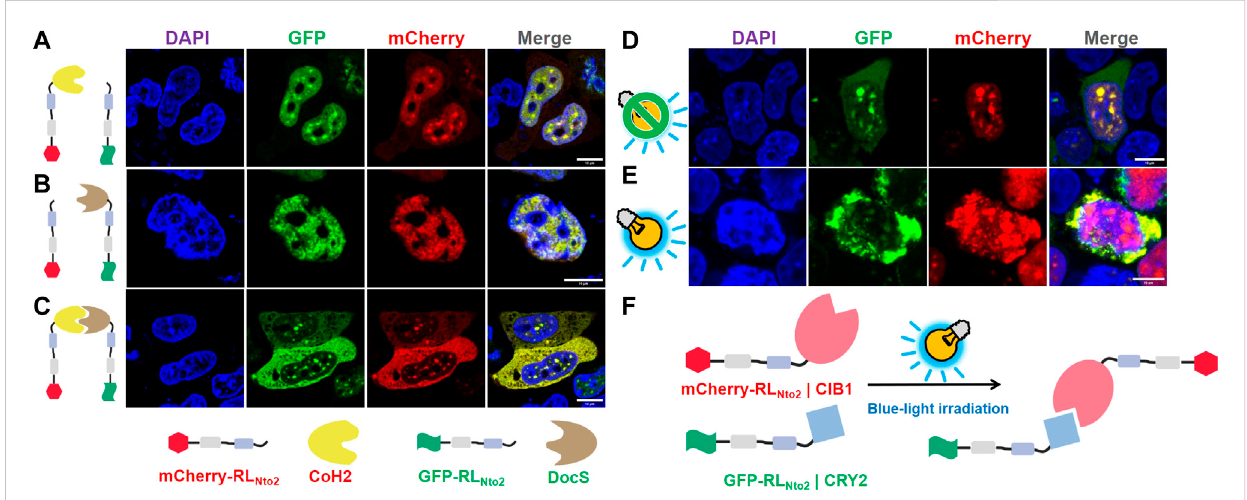
FIGURE 4 Restoration of repetition-level dependent cytoplasmic enrichment. (A) Confocal observation of HEK-29ET cells transfected with pCDNA3.1- mCherry-RL Nto2 -CoH2 and pCDNA3.1-GFP-RL Nto2 . (B) Confocal observation of HEK-29ET cells transfected with pCDNA3.1-mCherry-RL Nto2 and pCDNA3.1-GFP-RL Nto2 -DocS. (C) Confocal observation of HEK-29ET cells transfected with pCDNA3.1-mCherry-RL Nto2 -CoH2 and pCDNA3.1-GFP- RL Nto2 -DocS. (D,E) Confocal observation of HEK-29ET cells transfected with CDNA3.1-mCherry-RL Nto2 -CIB1 and pCDNA3.1-GFP-RL Nto2 -CRY2, treated with or without blue light, respectively. (F) Illustration for the blue-light induced interaction between recombinant mCherry-RL Nto2 -CIB1 and GFP-RL Nto2 -CRY2. Scalebars = 10 μ m.